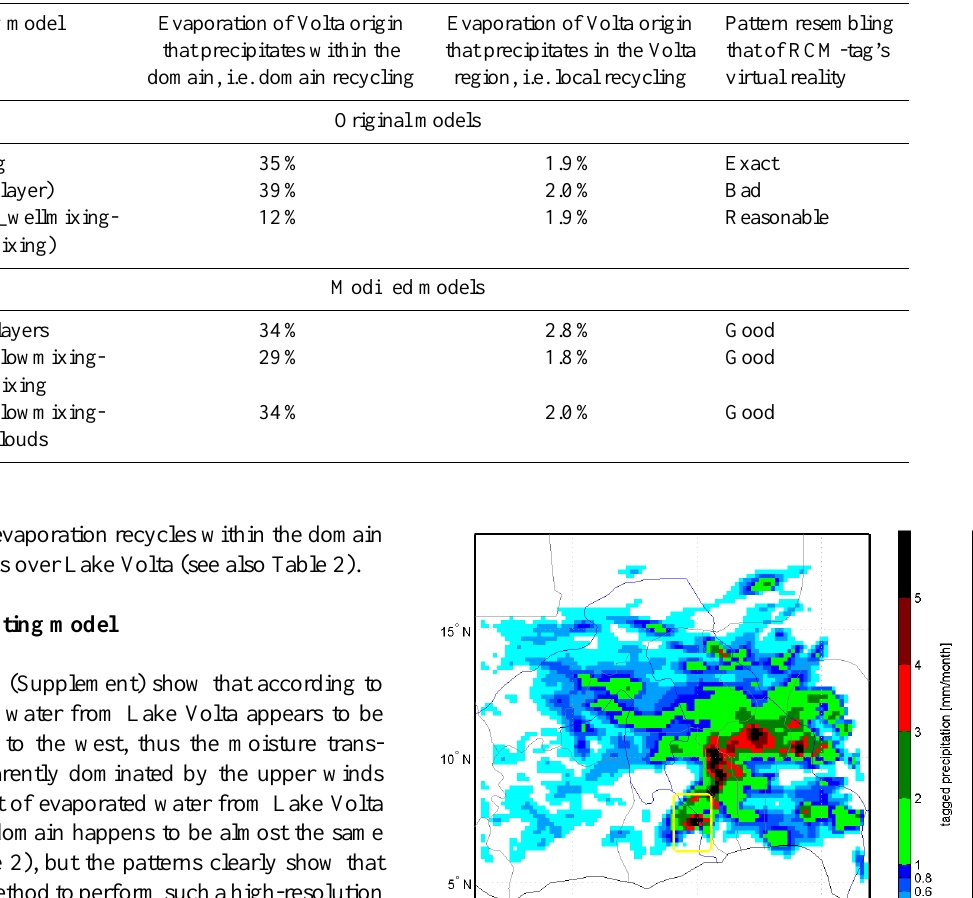
Table 2. The amount of evaporation from the Lake Volta region (Fig. 1), which recycles as precipitation within the domain and locally computed with different water tracking models. These results are for August 1998.